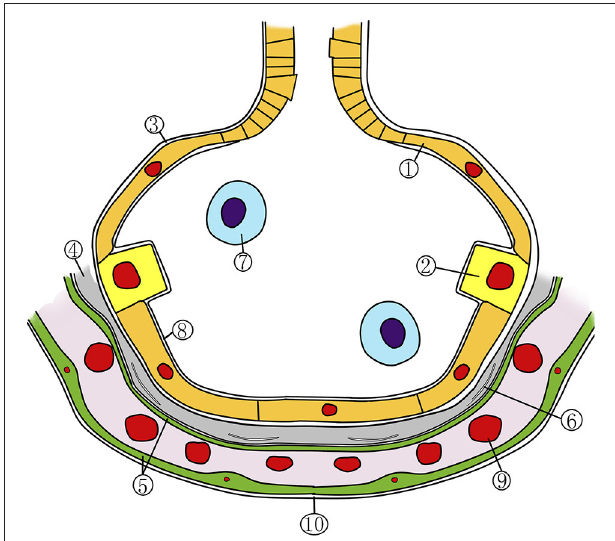
FIGURE 1 | Schematic representation of the normal alveolocapillary region. 1, alveolar type 1 cell; 2, alveolar type 2 cell; 3, basement membrane; 4, interstitium; 5, capillary endothelial cell; 6, fibroblast; 7, alveolar macrophage; 8, surfactant layer; 9, red blood cell; 10, capillary base membrane. Adapted with permission from van Ooij et al. (2013).